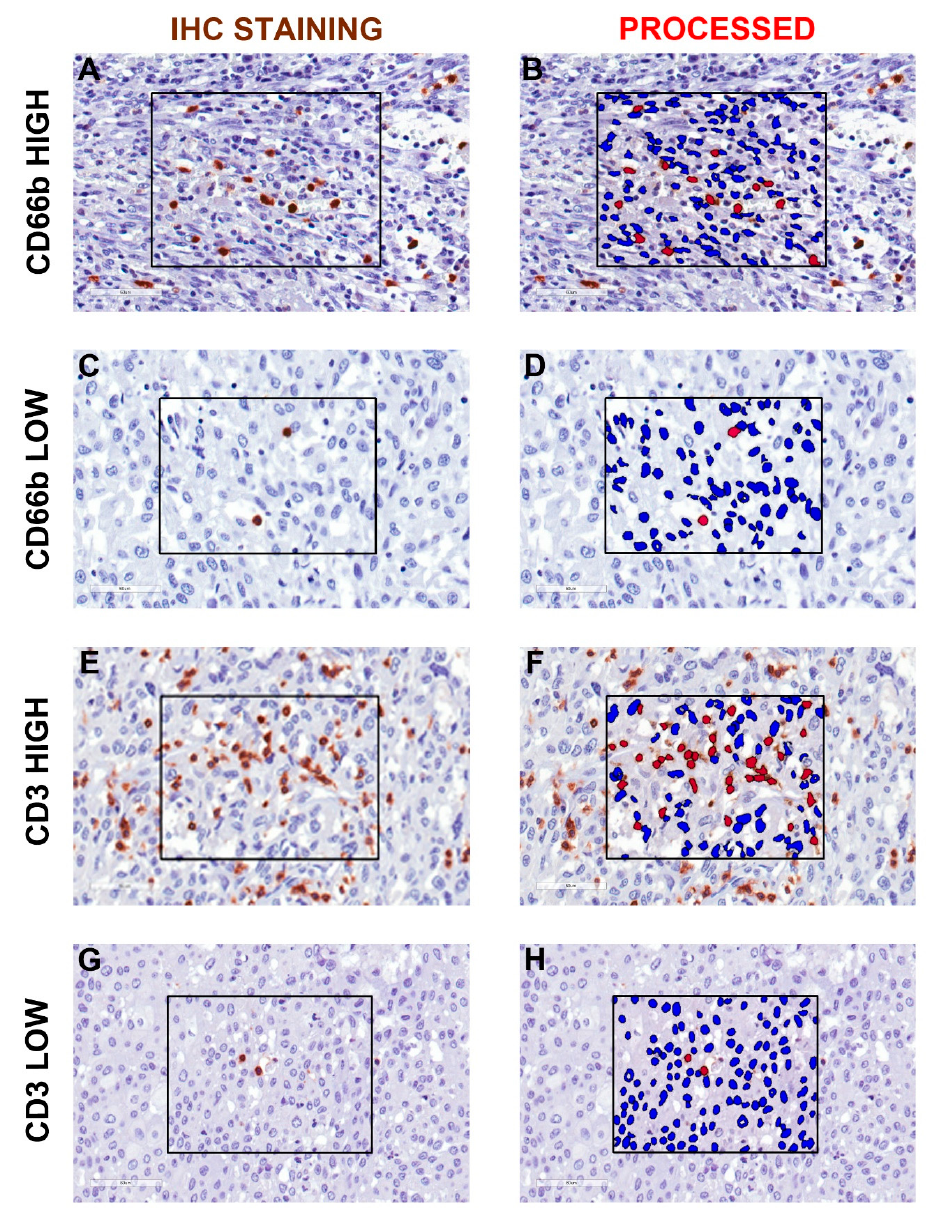
Figure 1. Representative image analysis for CD66b + TAN and CD3 + T cells in human MIBC. Sections are from four representative human MIBC (case #66, #31, #7 and #46) and stained as labeled and counterstained with hematoxylin ( A , C , E , G ). On the right column, the corresponding processed area is shown ( B , D , F , H ). Case with high and low density of CD66b + TAN ( A and C, respectively) and CD3 + T cells ( E and G, respectively) are displayed. Images acquired from digital slides using 400× magnification have been digitally resized using Adobe Photoshop.